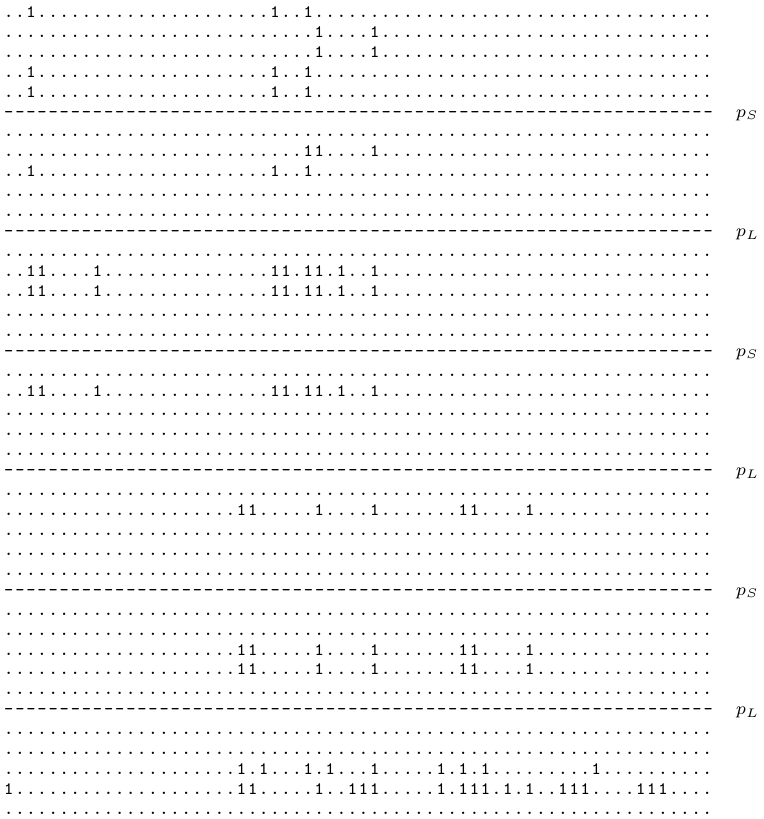
Figure 6: 4-round trail with 44 [5, 9, 7, 23] active Sboxes and weight 119 [10, 18, 21,